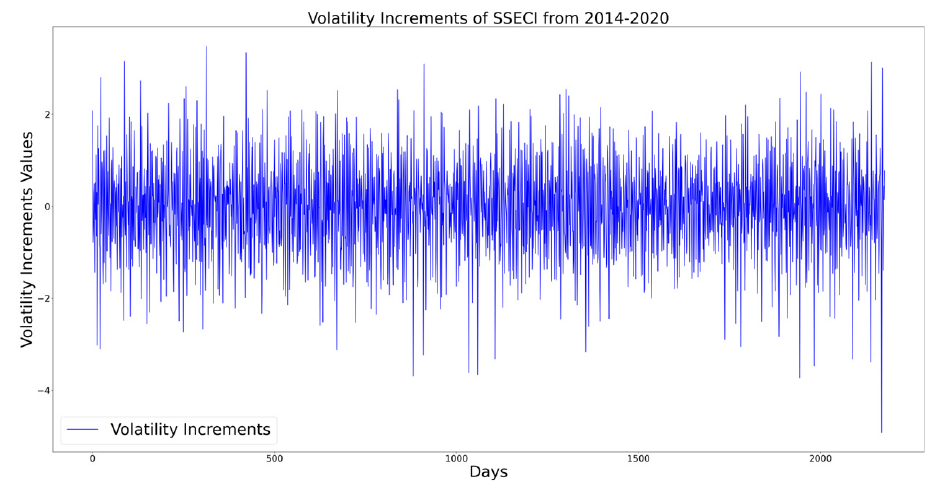
Table 1. Descriptive statistics for log return and volatility increments of SSECI.